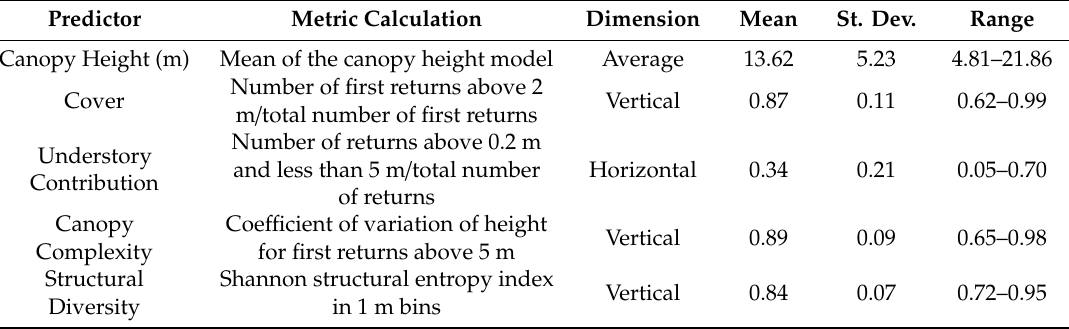
Table 1. Summary of calculated predictor at plot scale (100 m 2 ) across all plots at all sites. Predictor, method of calculation (Metric Calculation), dimension measured (Dimension), mean, standard deviation (St. Dev.), and range are presented for each variable. Height is expressed in meters, while remaining metrics are expressed in